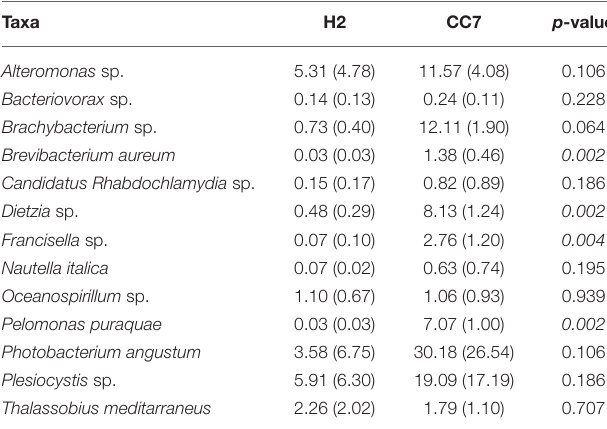
TABLE 3 | Differences in the average relative abundance in percent ( ± SD) of shared bacterial taxa (OTUs) between Exaiptasia H2 and CC7 core